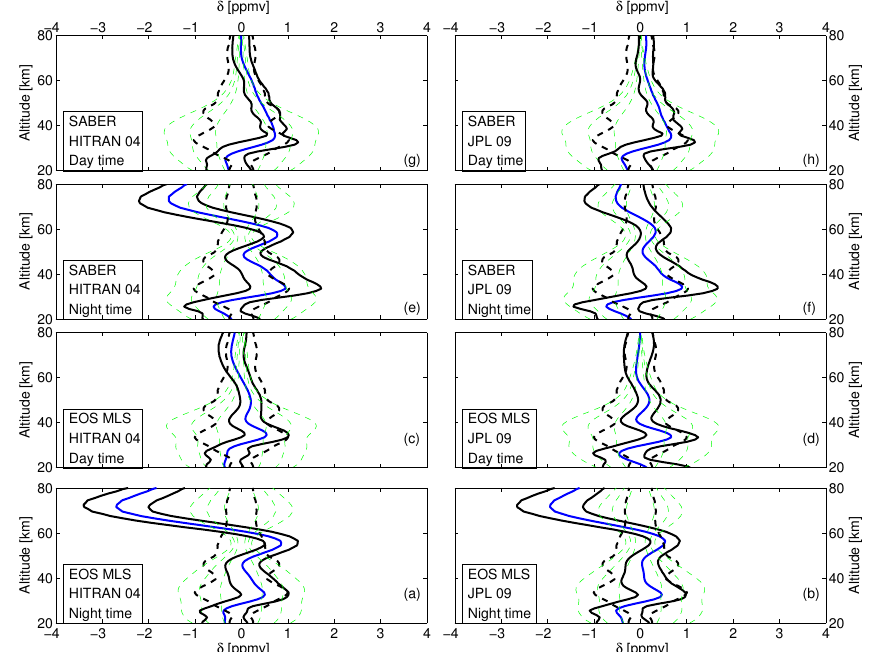
Fig. 10. Intercomparison of the OZORAM data set, using HITRAN 2004 (left column) and JPL 2009 spectroscopy (right column), respec- tively, to the measurements of EOS MLS (IM=MLS; lower two rows) and SABER (IM=SABER; upper two rows). The plots show the mean difference h δ x i=hˆ x IM − ˆ x OR i and the standard deviation of the differences of the difference profiles δ x (solid black). (solid blue; See q = S ii Sect. 3.1 for further details). The standard deviation of the h δ x i , s ii , is denoted by black solid lines, the black dashed lines denote δ x δ x q S ii the error of the difference . The green dashed lines mark the 10%, 20% and 30% (starting from the innermost line) ranges of the mean δ y ˆ x n ) OZORAM profile (1 /N P N n = 1 OR